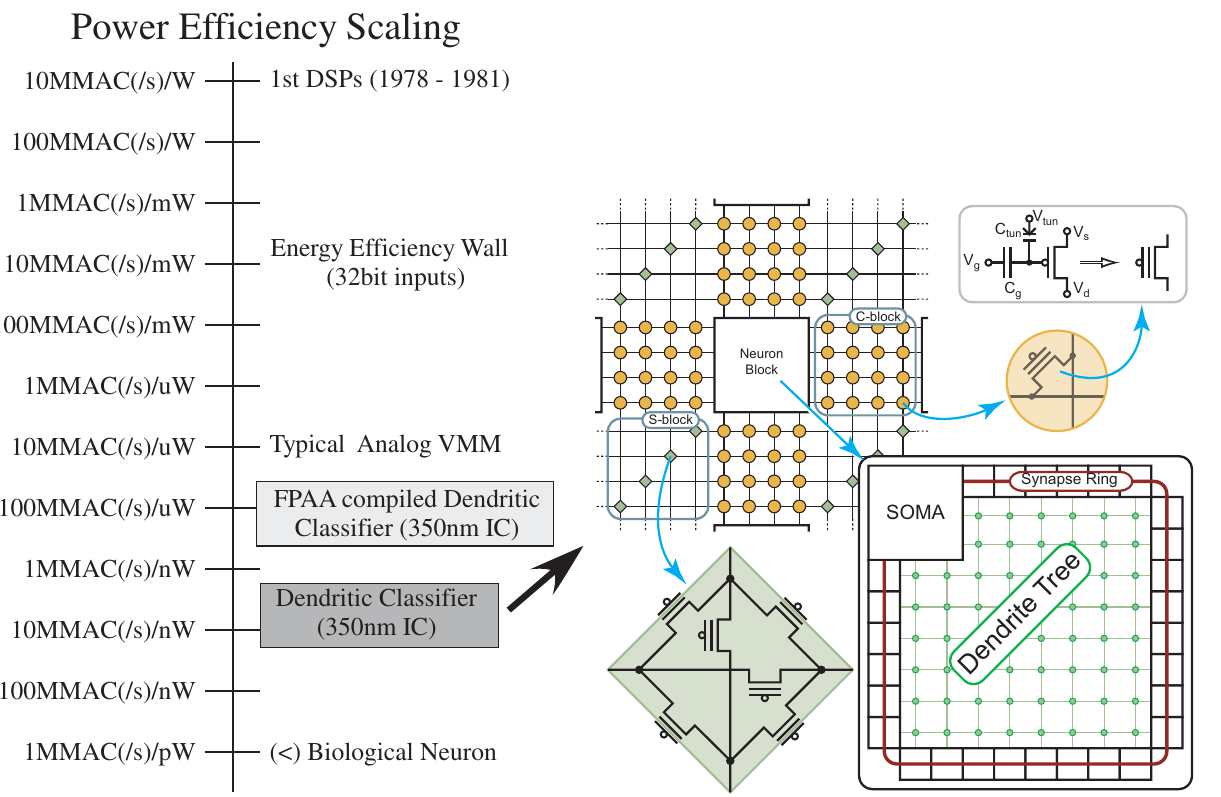
FIGURE 18 | Dendritic computation results in computational efficiency improvements over analog SP techniques. The first approach was a compiled FPAA design, showing an order of magnitude increase, with the second, more optimized configurable approach potentially enabling